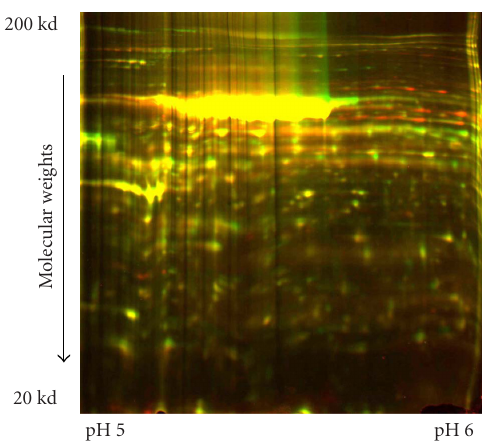
Figure 3. DIGE gel image of WNV-infected neurons and control (normal). WNV-infected neuronal protein and control neuronal protein are labeled with Cy3 and Cy5 respectively. The protein samples are mixed and run on an IPG strip of pH 5–6, sepa- rated on a 20cm × 20cm gel. Spots in green are upregulated, while spots in red are downregulated in WNV-infected neurons. The gel is then stained with Sypro Ruby and spots are picked, digested, and identified using mass spectrometry.